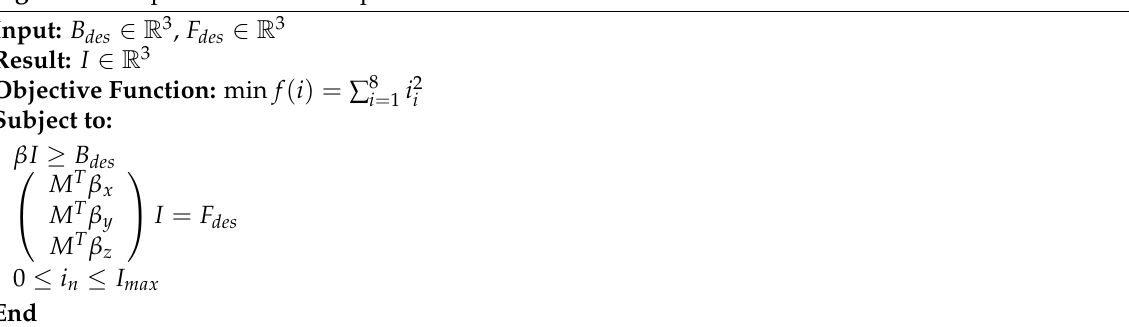
Algorithm 2 Optimization for Displacement Actuation